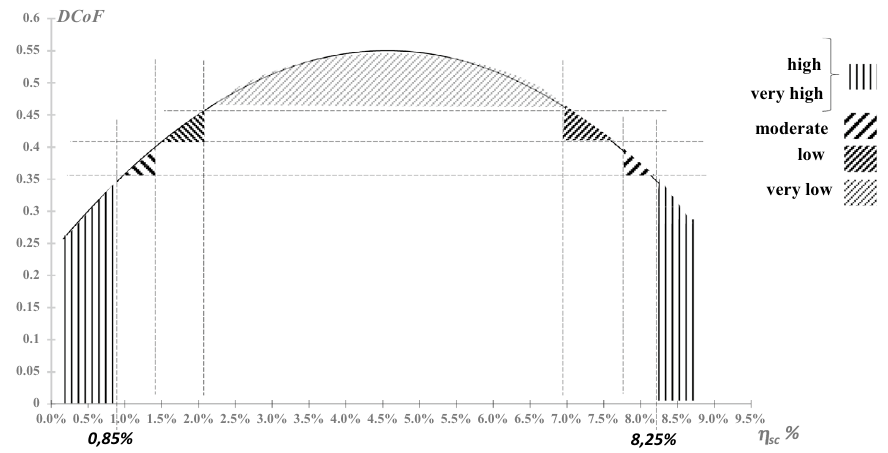
Fig. 8 Classification of slipping risk indices in relation to the sliding factor—contact η